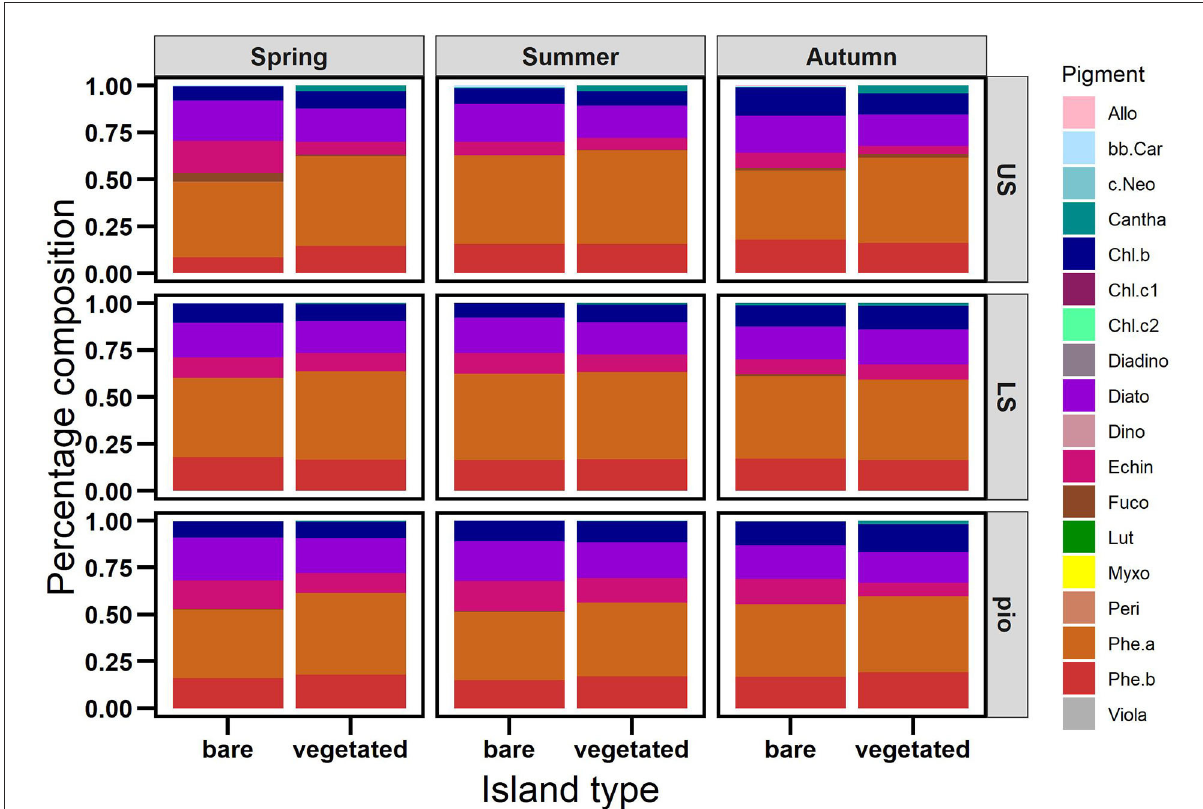
FIGURE7 Seasonal pigment:Chl-a ratios (expressed as percentage) on all three elevational levels: pioneer (pio), lower salt marsh (LS), and upper salt marsh (US) of the experimental islands of Spiekeroog (Pigment abbreviations: Allo, Alloxanthin; bb.Car, beta-carotene; c.Neo, 9’-cis-neoxanthin; Cantha, trans-canthaxanthin; Chl.b, chlorophyll-b; Chl.c1, chlorophyll-c1; Chl.c2, chlorophyll-c2; Diadino, trans-diadinoanthin; Diato, Diatoxanthin; Dino, Dinoxanthin; Echin, trans-echinenone; Fuco, Fucoxanthin; Lut, lutein; Myxo, myxoxanthophyll; Peri, Peridinin;